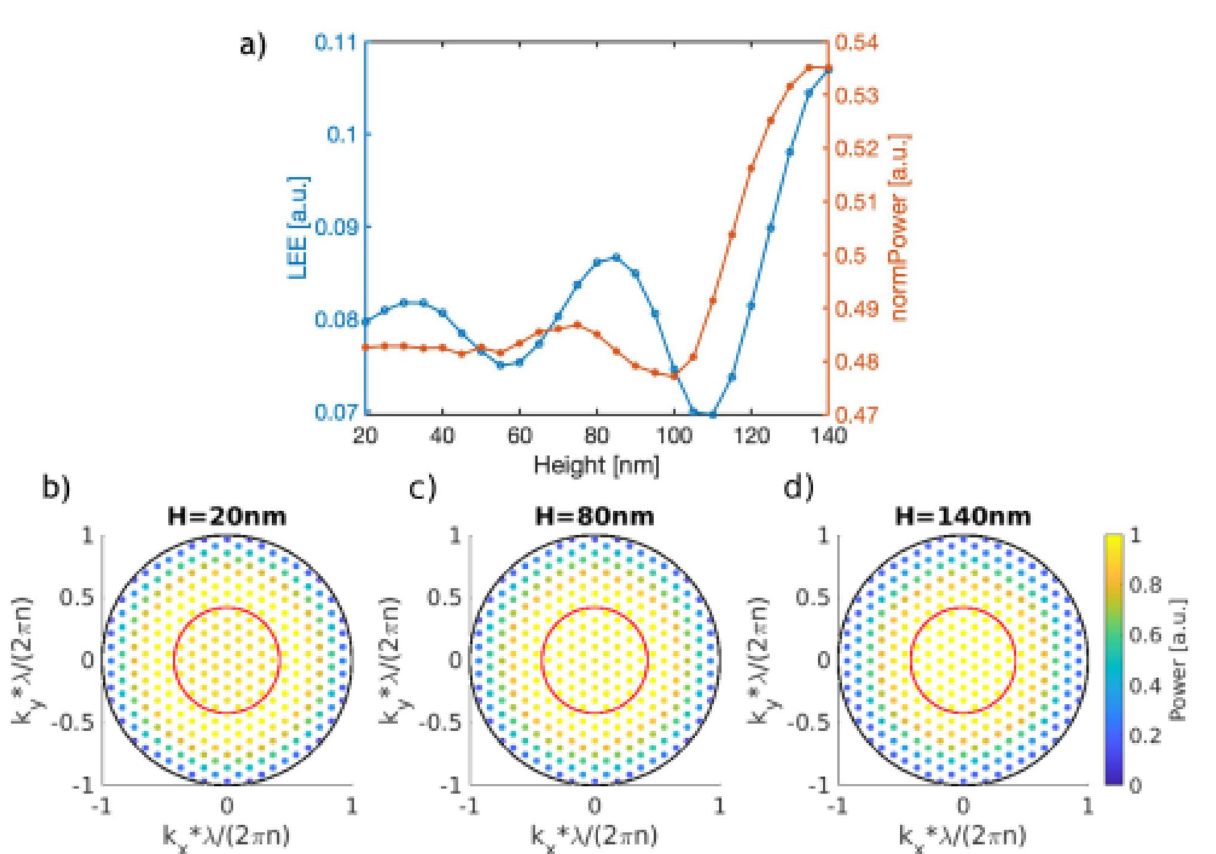
Figure 3. ( a ) LEE and normalized power emitted into the substrate as a function of the nanostructure height. ( b – d ) Normalized power distribution of modes emitted into the substrate for a height equal to 20 nm, 80 nm and 140 nm. The black outer circle represents the boundary of propagating modes, while the red inner circle represents the escape cone limited by